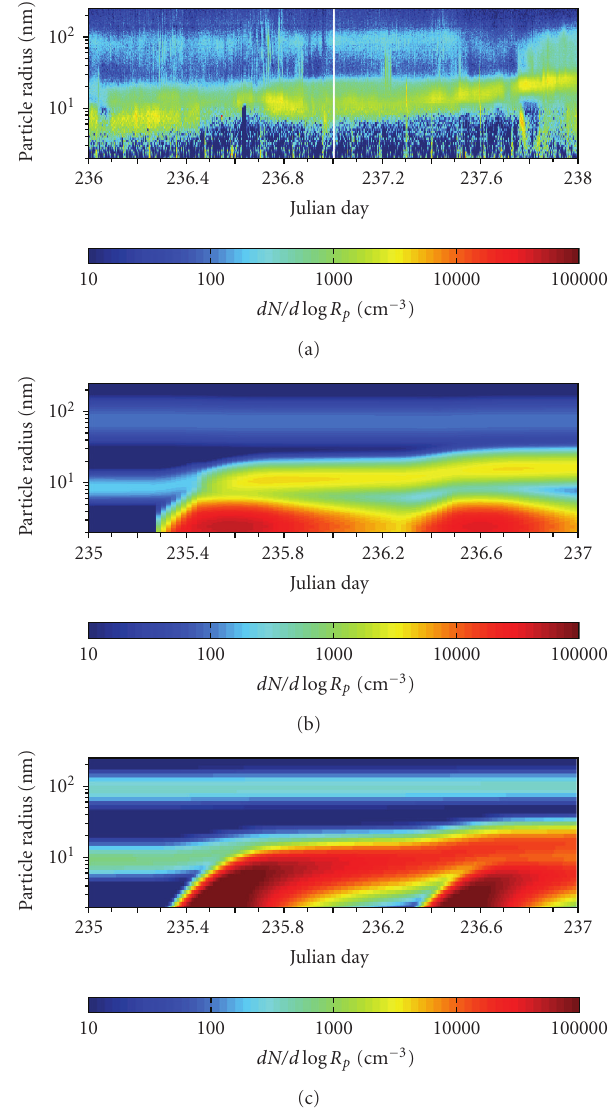
Figure 5: (a) Recorded open ocean nucleation event, (b) a modeled nucleation event beginning 15 hours before plume detection using modal model, and (c) a modeled nucleation event beginning 15 hours before plume detection using sectional